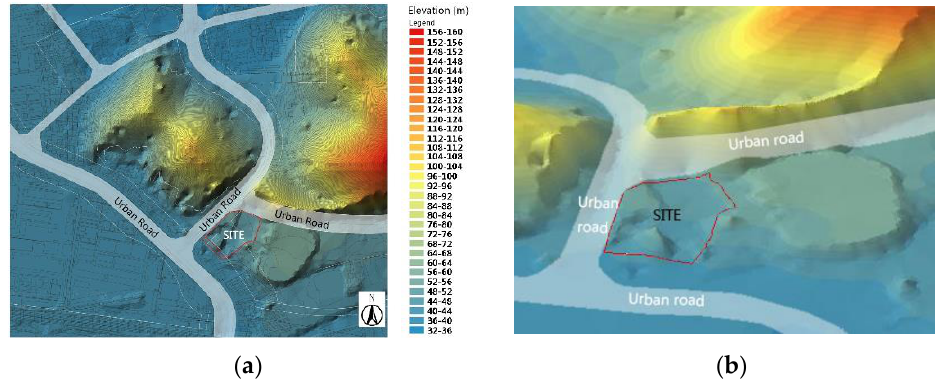
Figure 2. Digital elevation model of the study area: 2D view ( a ) and 3D view ( b ).